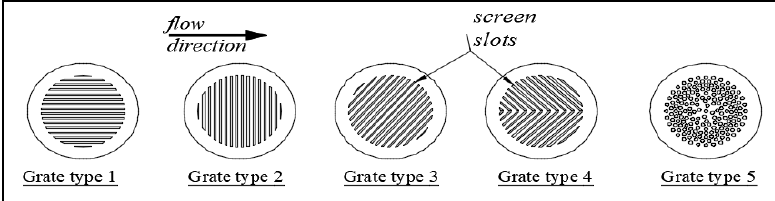
Figure 4. Sketch of different shapes of grates.